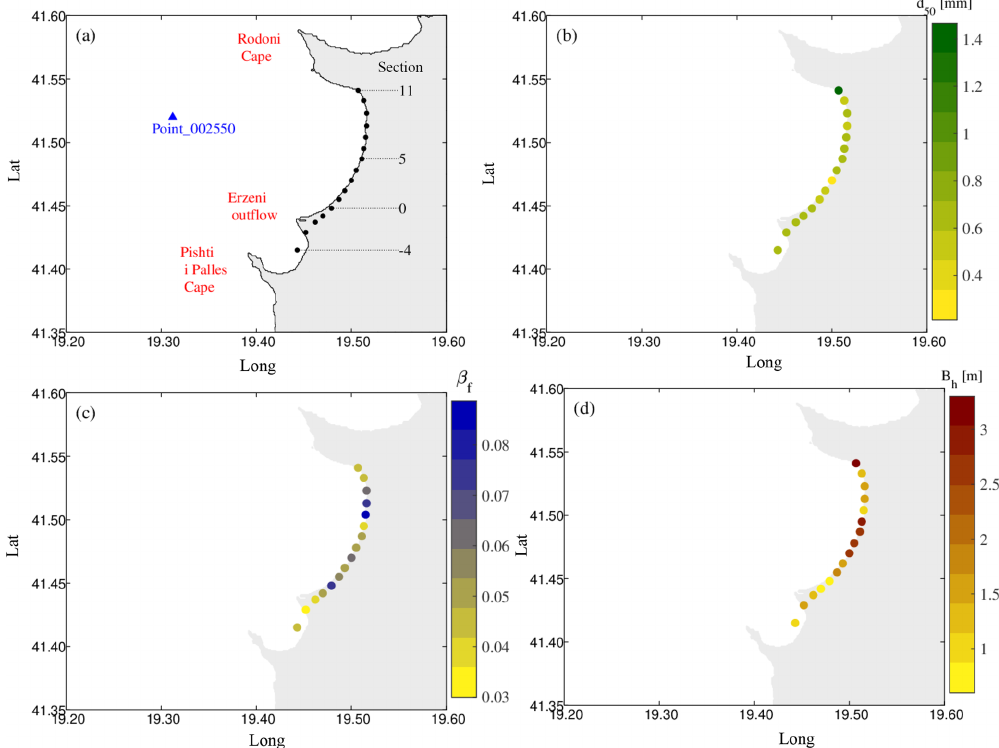
Figure 3. (a) Sampling locations for beach sections (from − 4 to 11, from south to north). Point_002550 represents the DICCA wave hindcast.